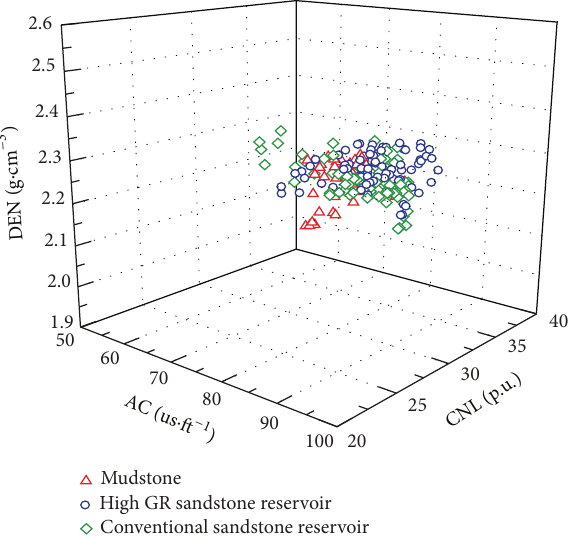
Figure 4: Cross plot of CNL, DEN, and AC for mudstone, conven- tional sandstone reservoir, and high GR sandstone